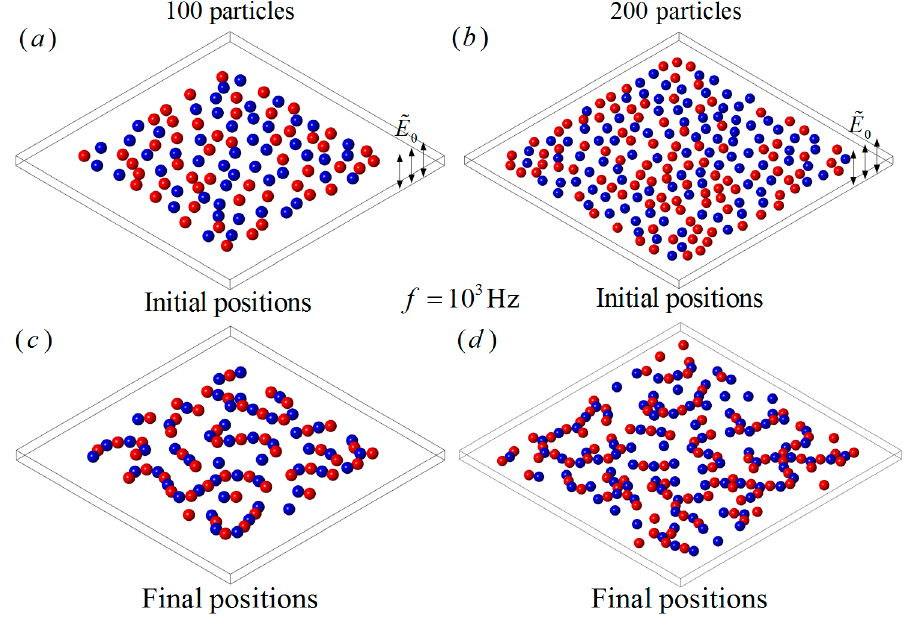
Figure 9. The DEP interaction of a large number of randomly distributed particles under a perpendicular field with (cid:101) E 0 = 0.02 and f = 10 3 Hz. ( a ) The initial positions of 100 dissimilar particles; ( b ) the initial positions of 200 dissimilar particles; ( c ) particle chains of 100 dissimilar particles; ( d ) particle chains of 200 dissimilar particles. The blue and red colors denote pDEP and nDEP particles, respectively.